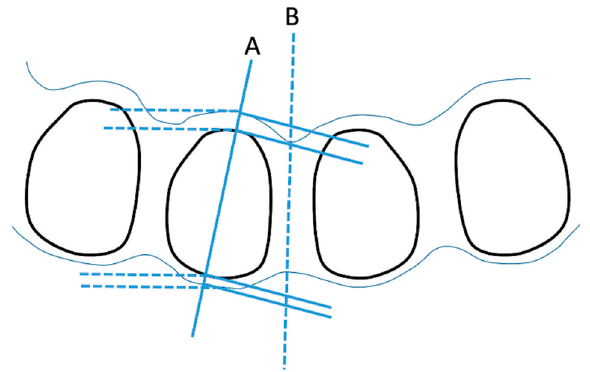
Figure 4. Four mandibular incisor roots were sectioned in the transverse plane to illustrate how the reference plane affects the alveolar bone thickness and root diameter. From the CBCT images, the measurements were performed perpendicular to the cut along the long axis ( A ). From the cephalograms, the measurements were perpendicular to the midline ( B ). The most prominent points in both